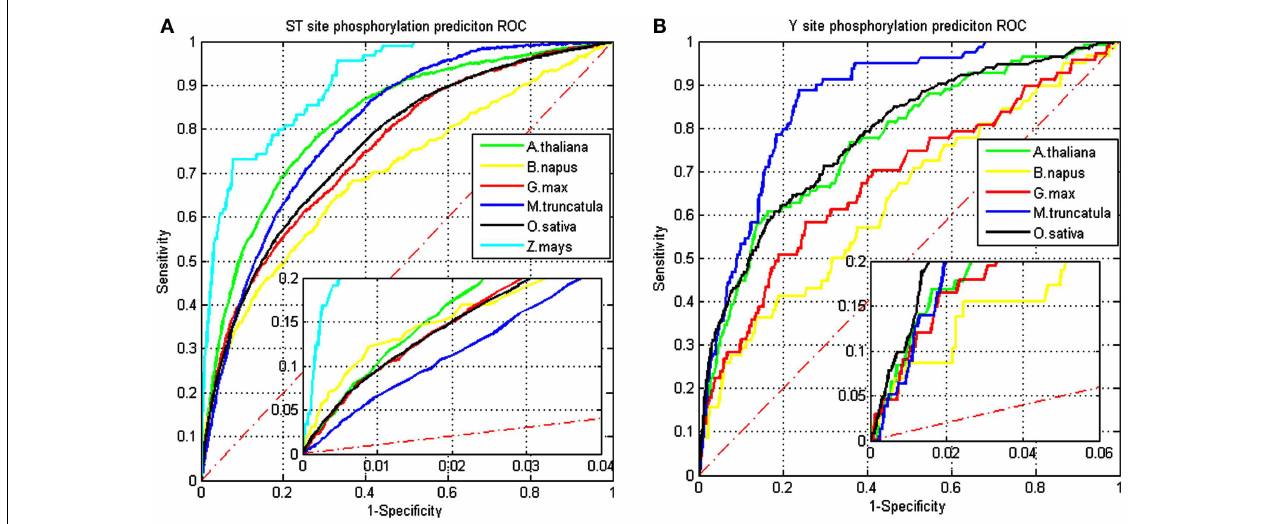
FIGURE 2 | Receiver operating characteristic curves for testing on different organisms using the trained model from A. thaliana : (A) curves for S/T site predictions and (B) curves forY site predictions.